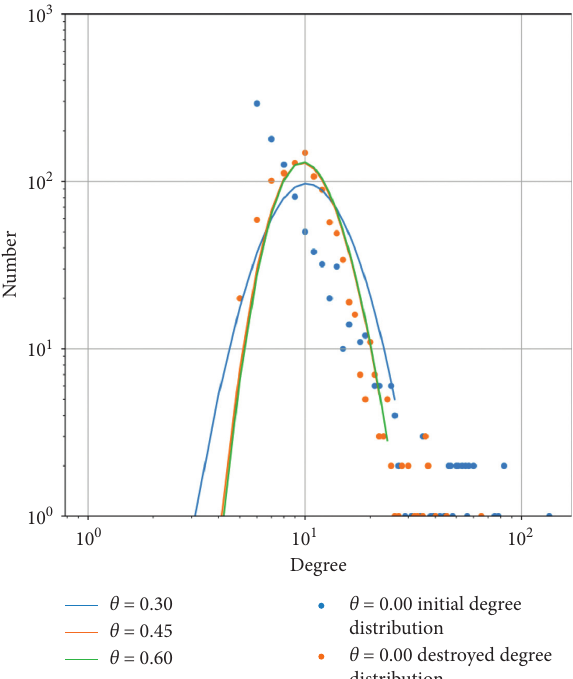
Figure 6: Degree distribution of the BA network in different similarity thresholds. We conducted many experiments on the BA network and obtained its degree distribution. We mainly selected the evolution results of 2000 iterations when θ is equal to 0, 0.15, 0.3, 0.45, and 0.6. When θ is greater than 0.6, the evolution result is similar to the result of θ � 0.6. The blue scatter plot shows the degree distribution when θ � 0, which is the degree distribution of the initial network. The green scatter plot is the degree distribution when θ � 0.15. A scatter plot indicates that it follows a power-law distribution. When θ > 0.15, the original distribution is destroyed and gradually becomes a lognormal distribution, and we use a curve to represent the changing trend of this lognormal distribution. The blue, orange, and green curves, respectively, represent the degree distribution when θ is equal to 0.3, 0.45, and